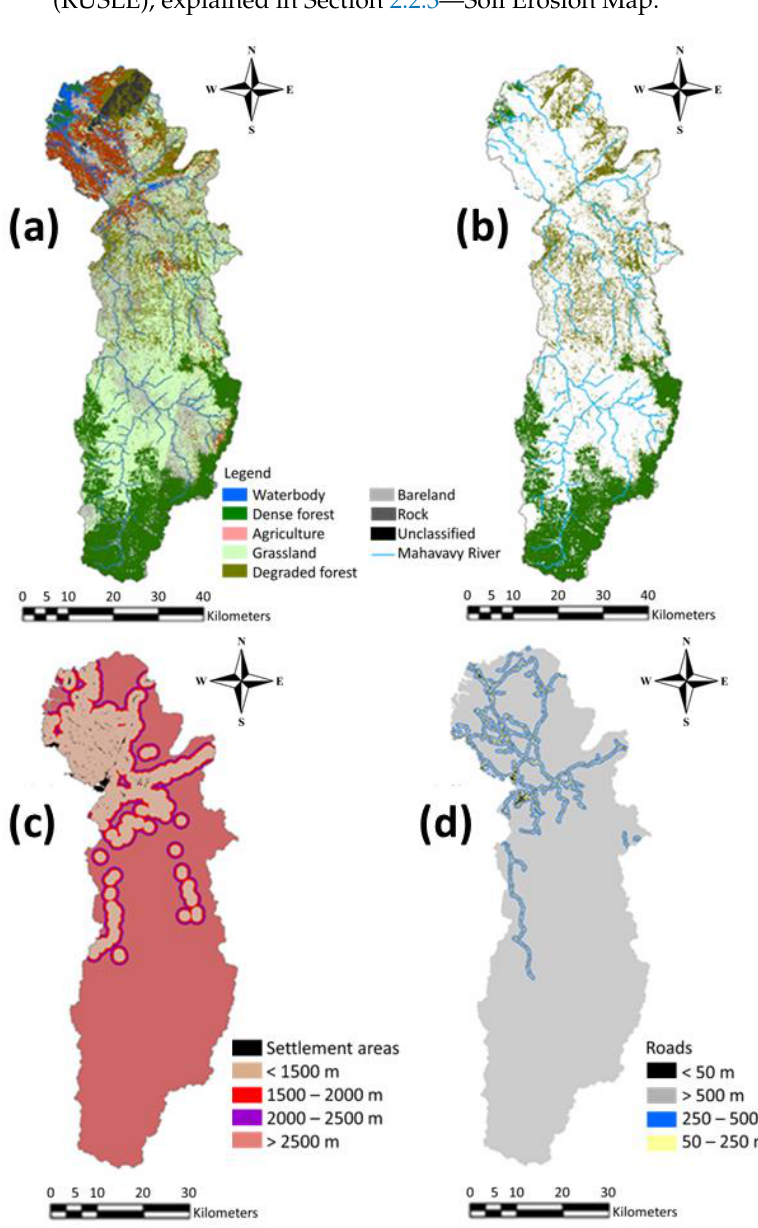
Figure 2. Criteria for the land suitability analysis for priority restoration areas. ( a ) LULC, ( b ) Forest cover, ( c ) distance from settlements, ( d ) distance from